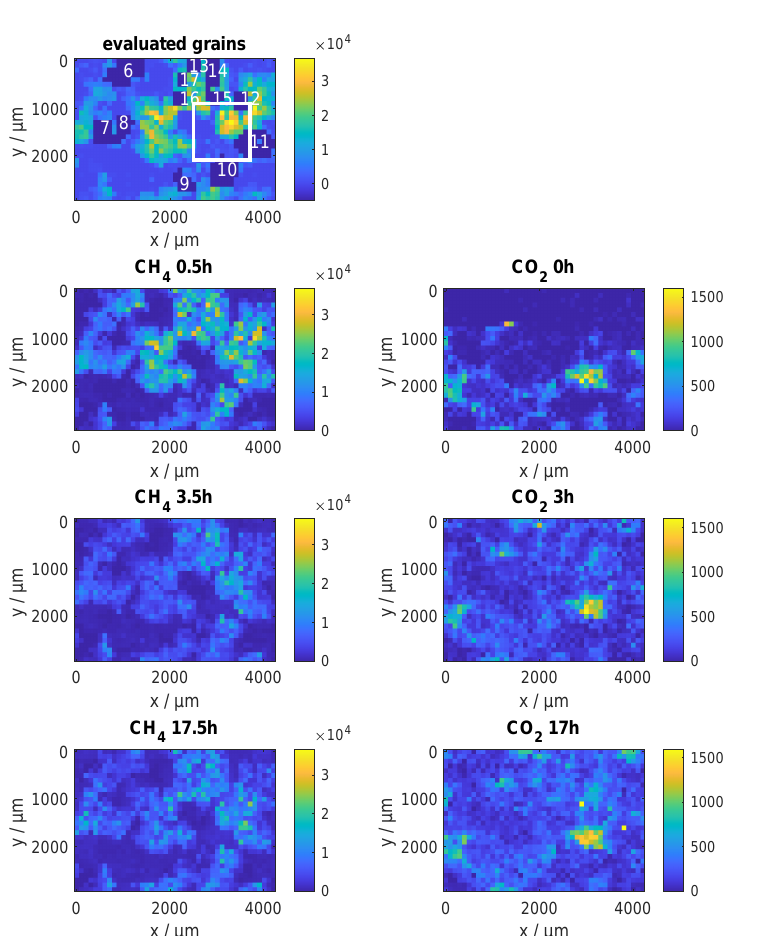
Figure 11. CH 4 and CO 2 hydrate maps of experiment Flow during the flow period at 0 h, 3 h (before stop of flow), and 17 h (after reinstallation of flow conditions). The white rectangle marks the location of the smaller FOV, and the positions of the evaluated gas-hydrate grains are marked as dark blue areas.